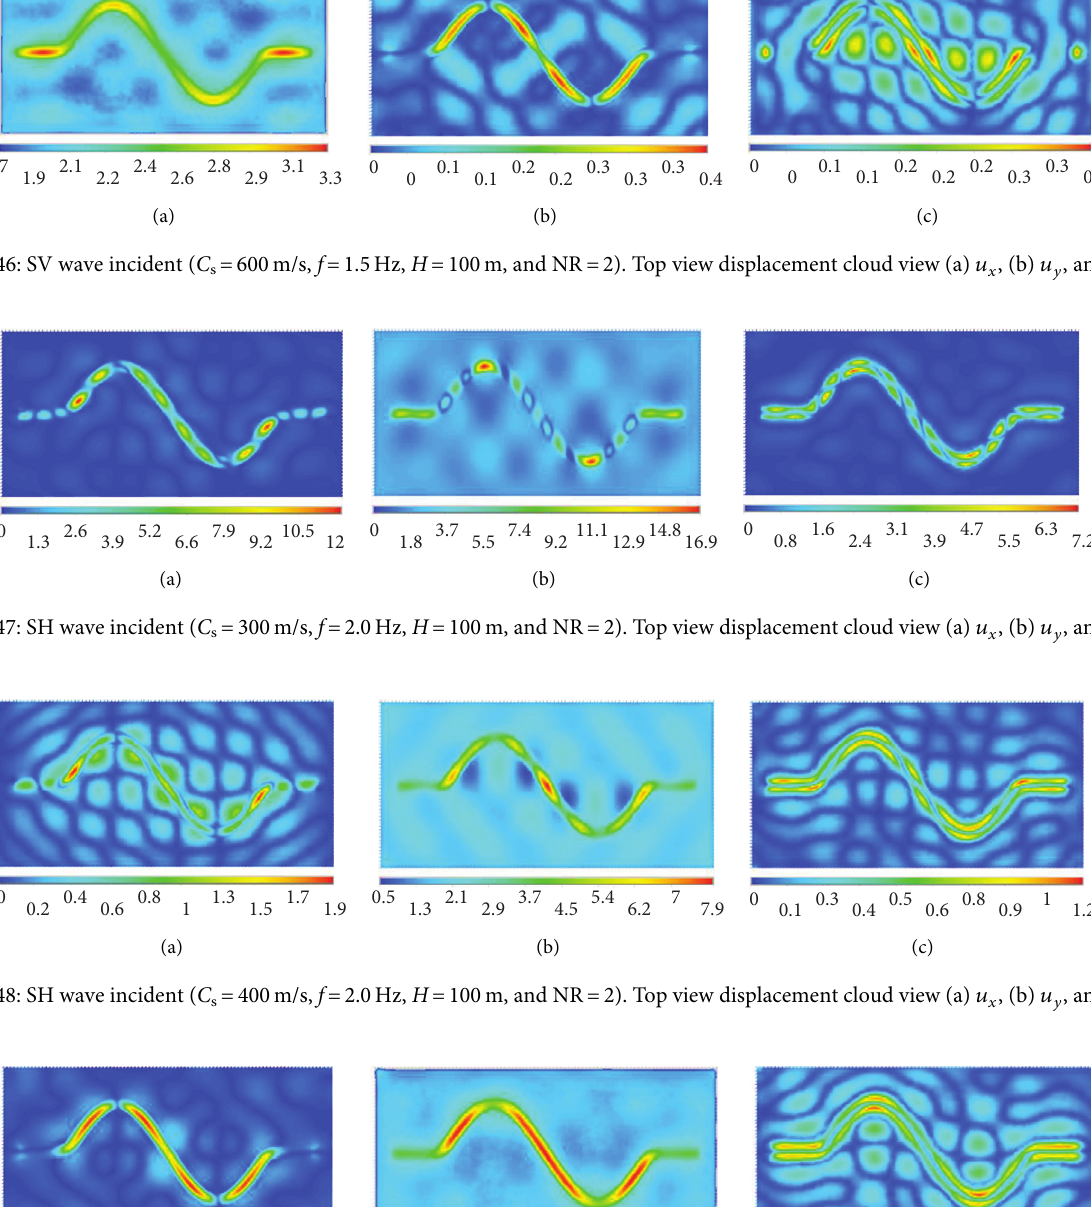
� 500m/s, f � 2.0Hz, H � 100 m, and NR � 2). Top view displacement cloud view (a) u s